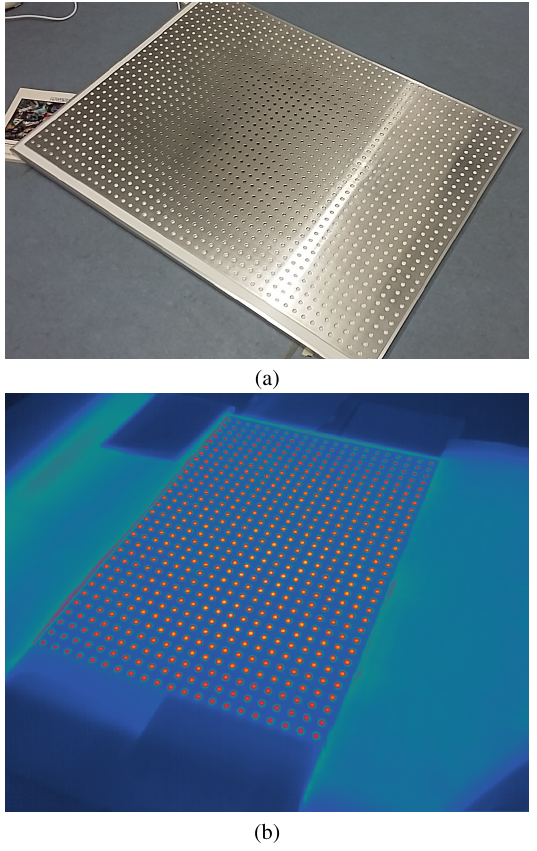
Figure 3. The designed calibration pattern (a) and how the pattern is shown in the thermal infrared domain (b) adjusted for detection of centers of circles and for using thermal images. The original workflow of the calibration toolbox was kept the same, but the procedure for extraction of the grid points was changed to detect circle centers instead.